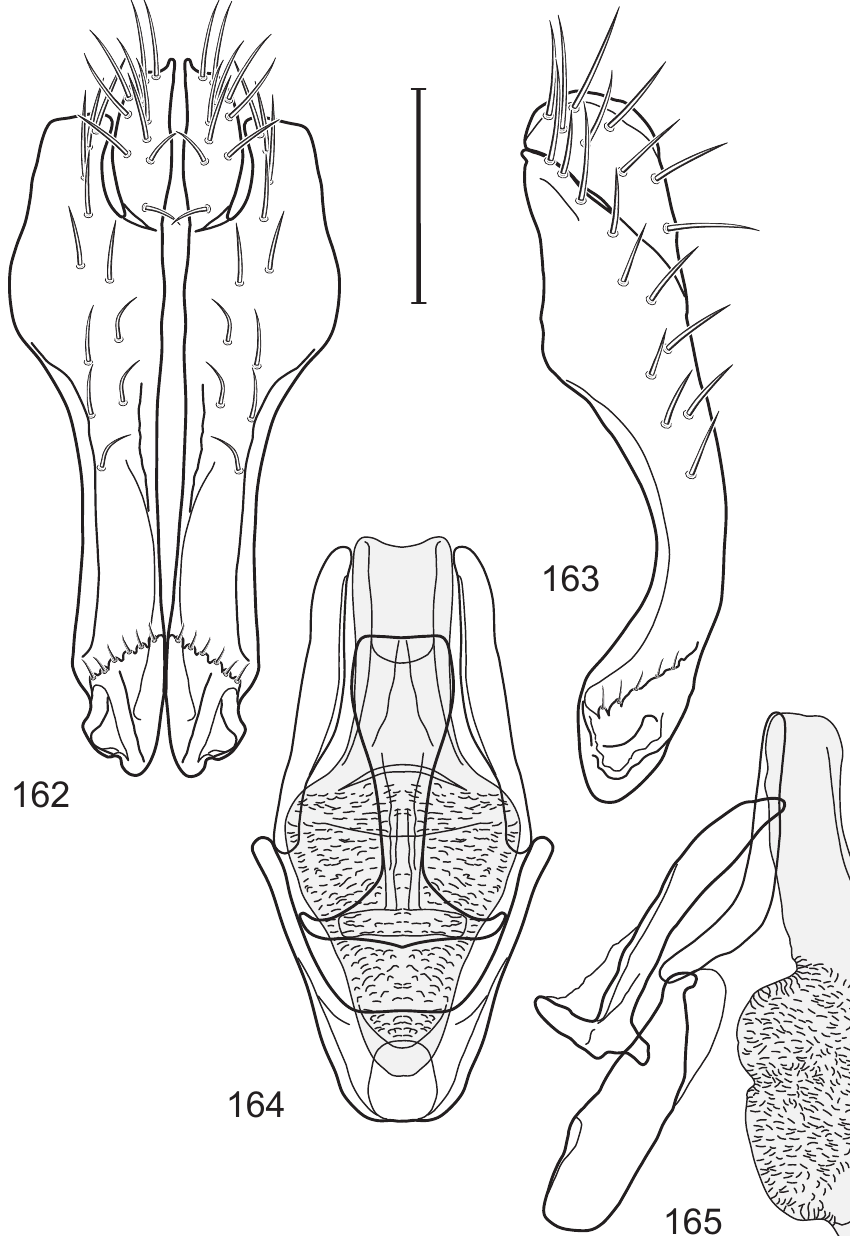
Figures 162–165. Hydrochasma edmistoni sp. n. (Dominican Republic. La Vega: La Vega) 162 epan- drium and cerci, posterior view 163 same, lateral view 164 internal structures of male terminalia (aedeagus [shaded], phallapodeme, gonite, hypandrium), ventral view 165 same, lateral view. Scale bar = 0.1